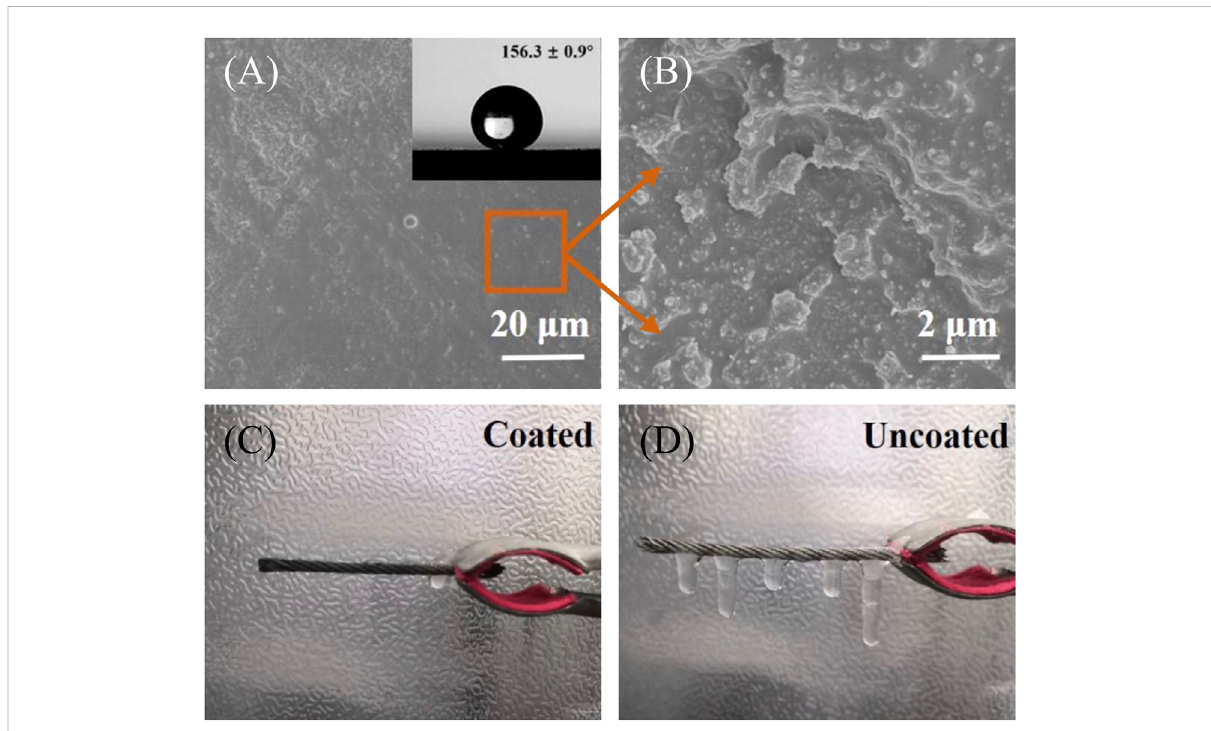
FIGURE 2 SEM images of (A,B) the over and the partially-enlarged views of the F-SiO 2 coating (Cao et al., 2022). (C,D) Test of anti-icing performance simulated conductor (Cao et al.,